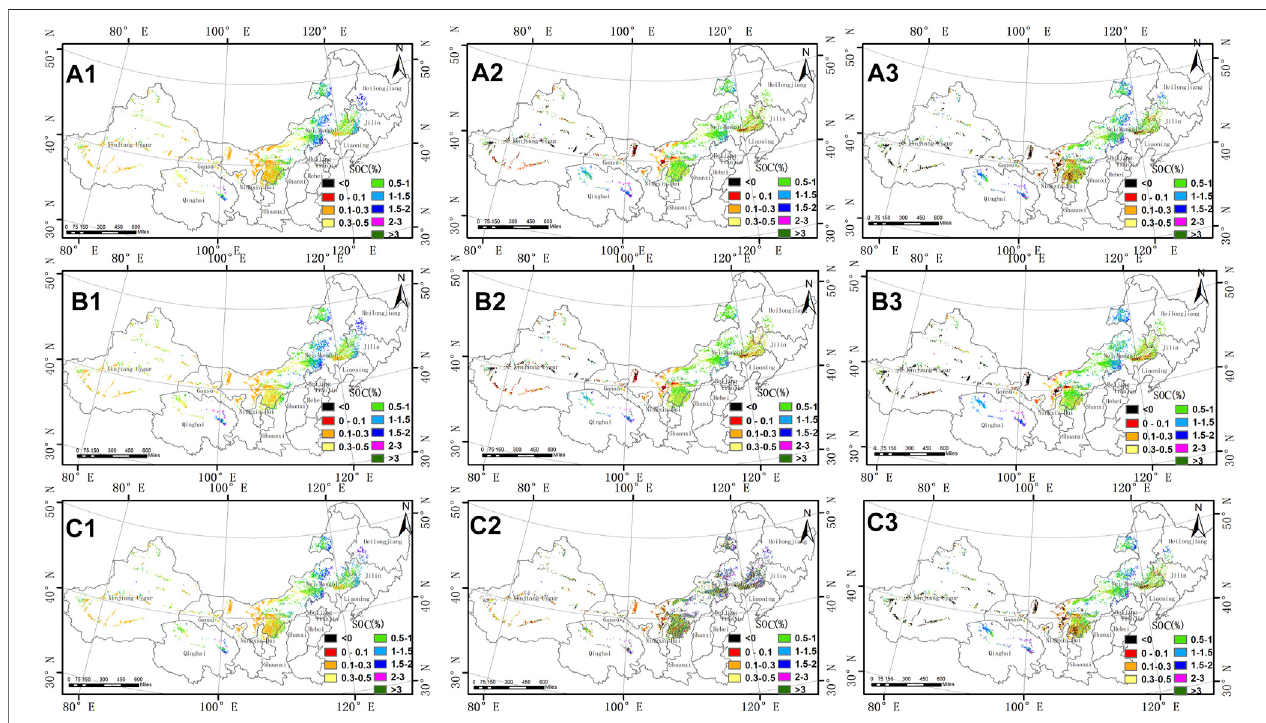
FIGURE 6 | Spatial distribution of soil organic matter (SOM) content. A,B, and C refer to covariate sets A,B, and C, respectively; 1, 2, and 3 represent different modeling techniques, i.e., random forest (RF), support vector machine (SVM), and multiple linear regression model (MLR), respectively.